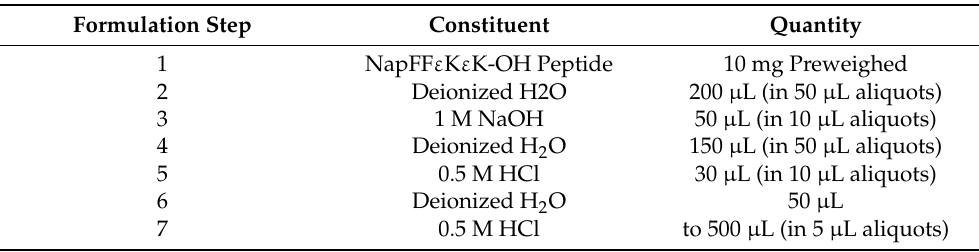
Table 1. Stepwise formulation of a self-assembling pH-triggered 2% w / v NapFF ε K ε K peptide